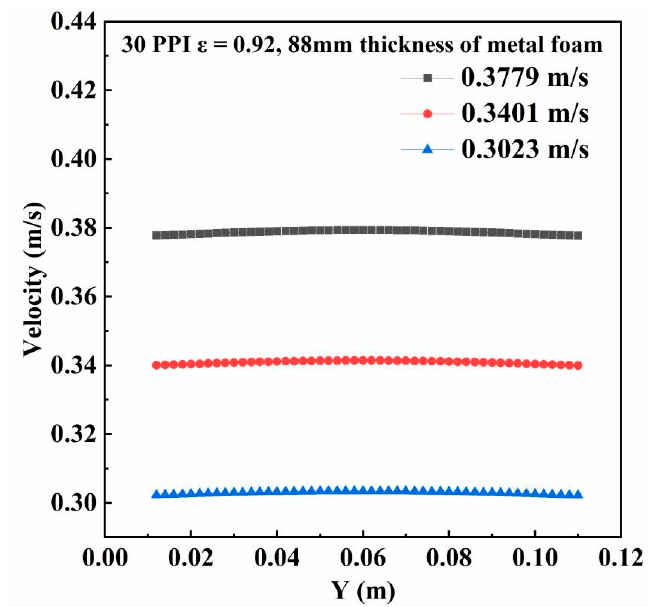
Figure 6. Velocity profile for 30 PPI 0.92 porosity with 88 mm thickness metal foam at three different velocities . different